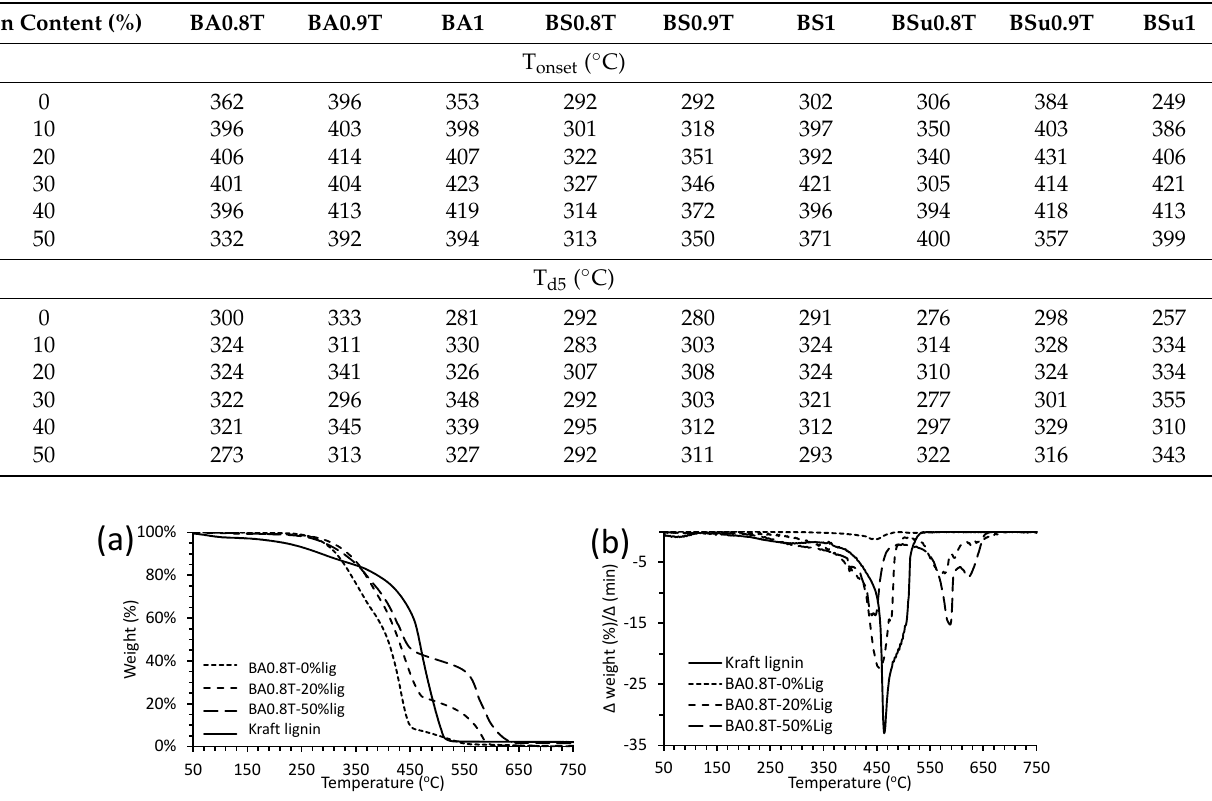
Table 6. Major thermal degradation onset temperature (T onset ) and T d5 temperature for the various lignin-copolymers determined by TGA.